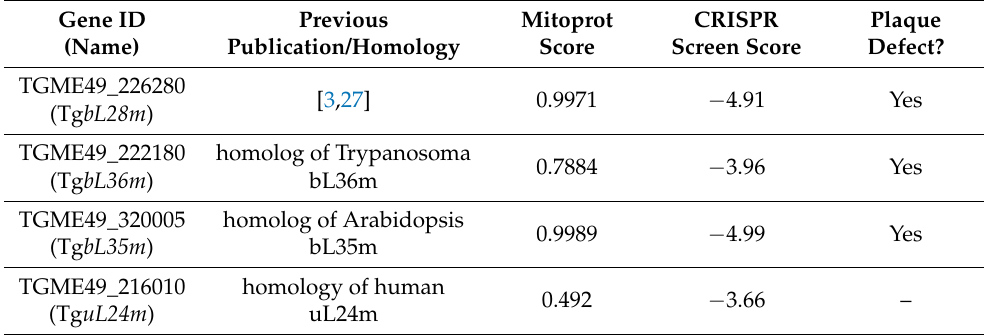
Table 1. Summary of the four Toxoplasma LSU component homologs studied in this